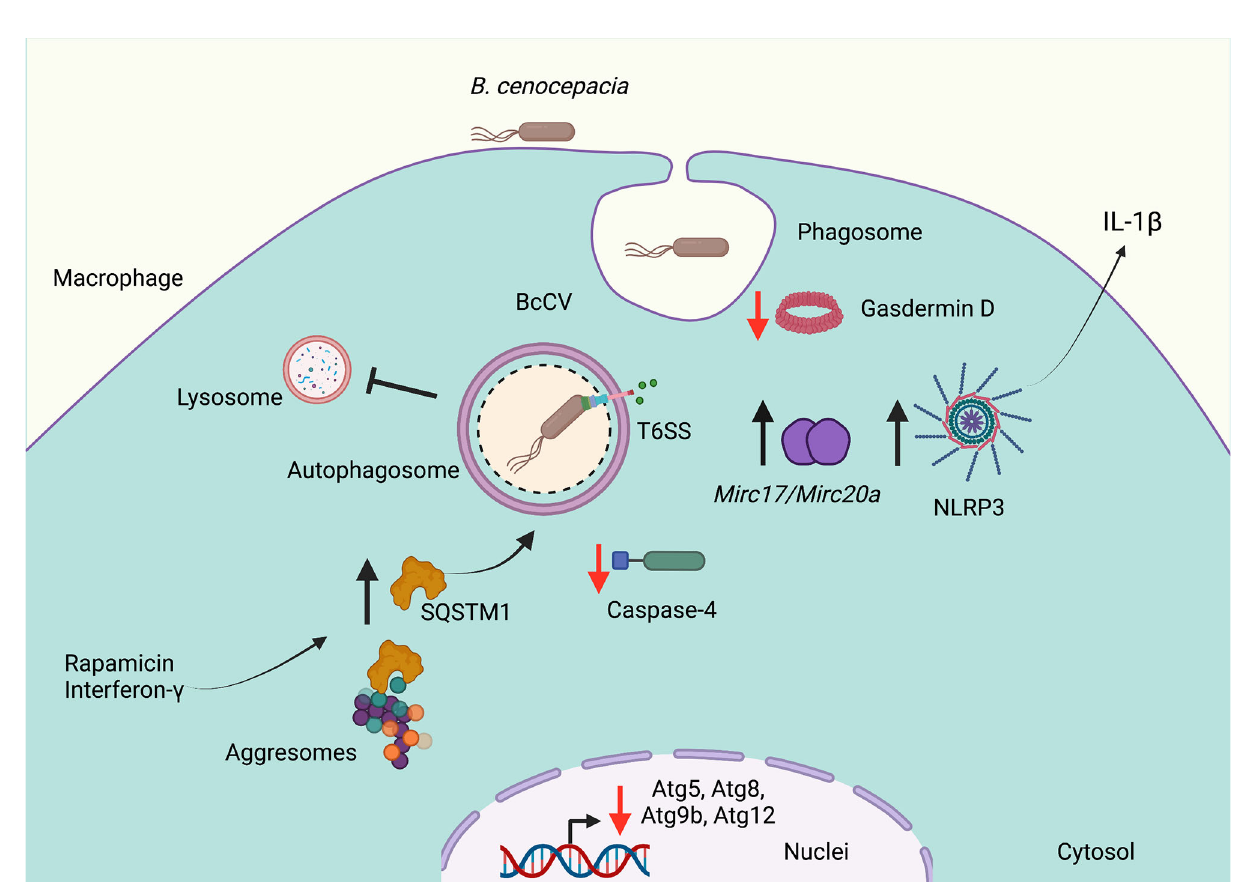
FIGURE 1 | Burkholderia cenocepacia subverts autophagy in cystic fi brosis. Burkholderia cenocepacia invades phagocytic cells and resides in a vacuole (BcCV) that shows delayed fusion with lysosomes. The activity of the Type VI Secretion System (SST6) damages the membrane of the BcCV, allowing leakage of its content to activate the in fl ammasome NLRP3 and to release IL-1 b . The damaged membrane of the BcCV might be surrounded by autophagosome membranes. Bacterial infections decrease the Atg9b, Atg5, Atg12 , and Atg8 transcription. The decrease of Gasdermin D and caspase-4 expression in B. cenocepacia -infected macrophages decreases the autophagosome formation. The downregulation of Mir17 and Mir20a partially restored the autophagy de fi ciency. Rapamycin or IFN- g stimulation induces the release of SQSTM1 from aggresomes to increase the mature autophagosome formation. Red arrows indicate decreased autophagy, and black arrows indicate increased autophagy. Created with